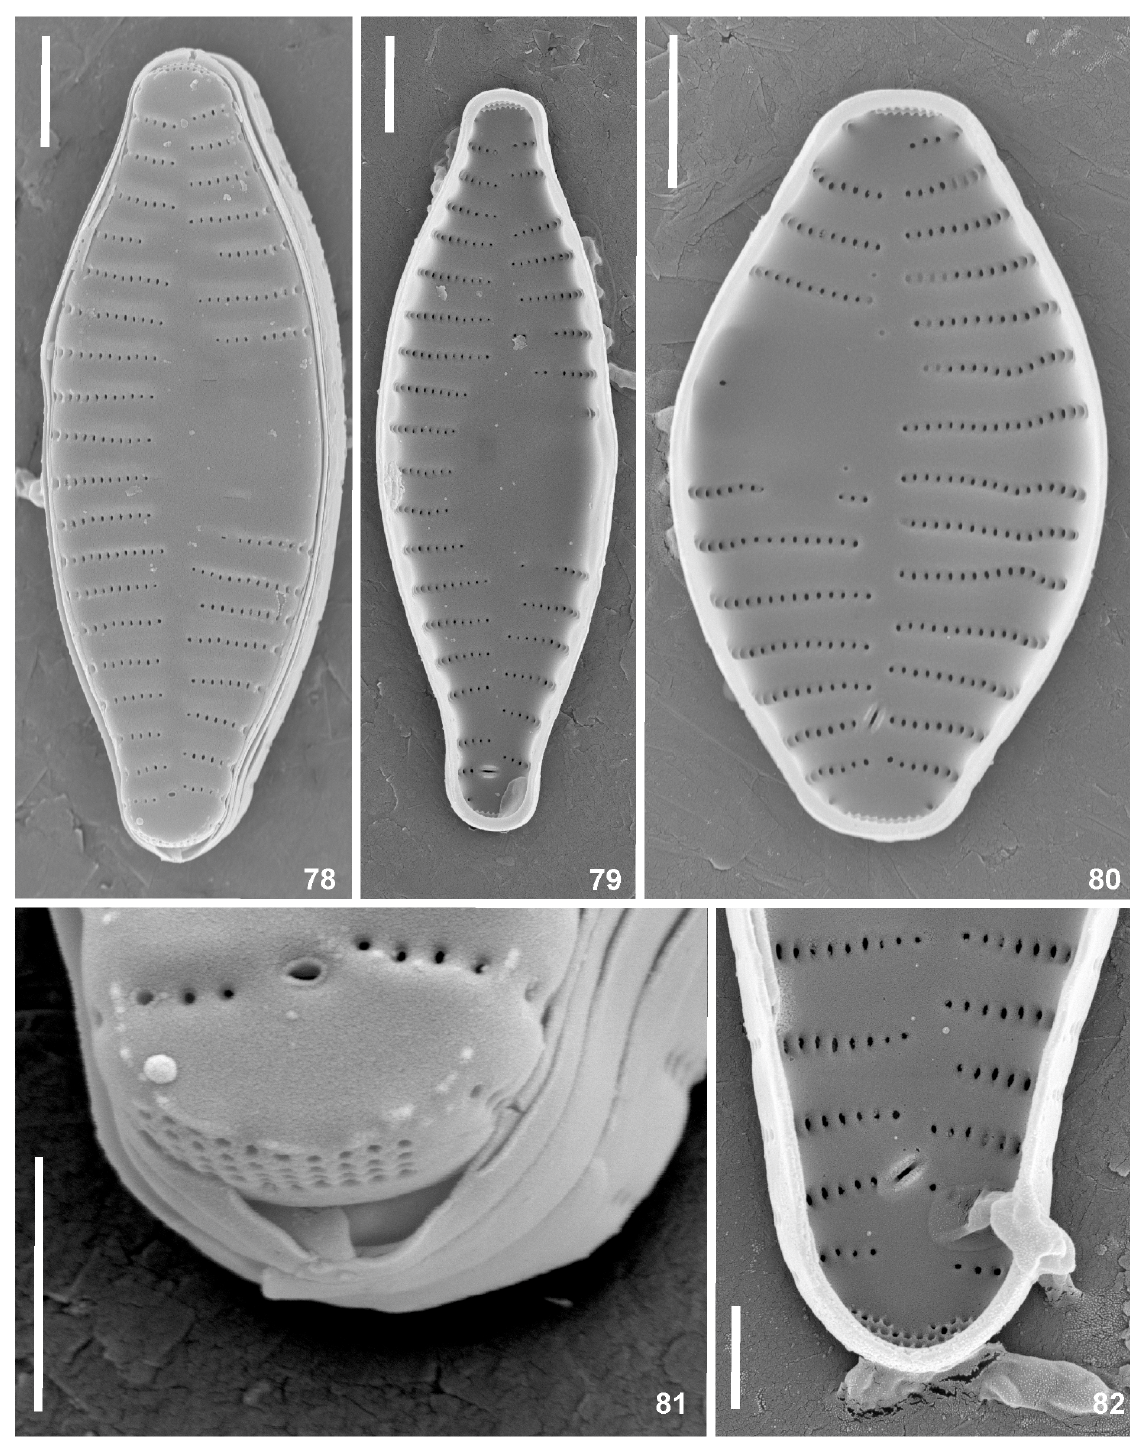
Figs 78-82. Scanning electron microscope images of Fragilaria rinoi Almeida & C.Delgado sp. nov. from Mogofores (river Cértima, Vouga river basin), 21 Mar. 2012 (Holotype BM 101 794). 78 . Complete valve in external view. 79–80 . Complete valves in internal view. 81 . Detail of an apex in external view, with the apical pore field and rimoportula. 82 . Detail of an apex in internal view, with the rimoportula clearly visible. Scale bars: 78–80, 82 = 2 µm; 81 = 1